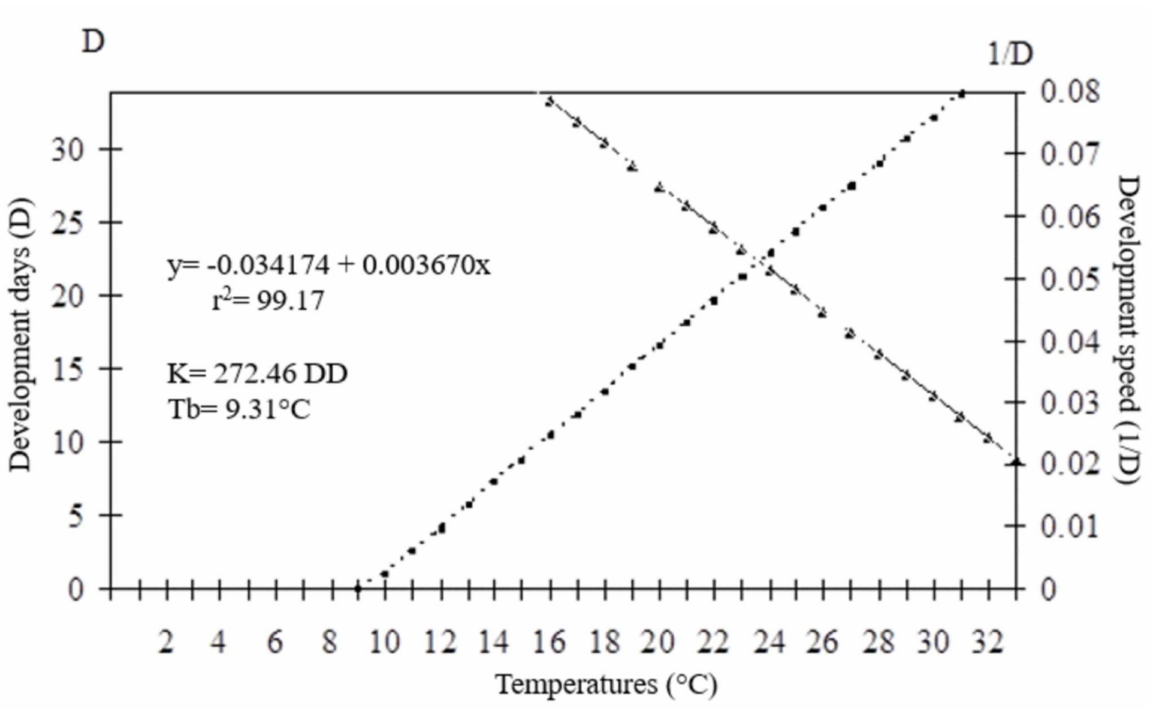
Figure 6. Duration (days) and developmental speed of Telenomus podisi in eggs of Euschistus heros at different temperatures. K: thermal constant; Tb: base temperature.